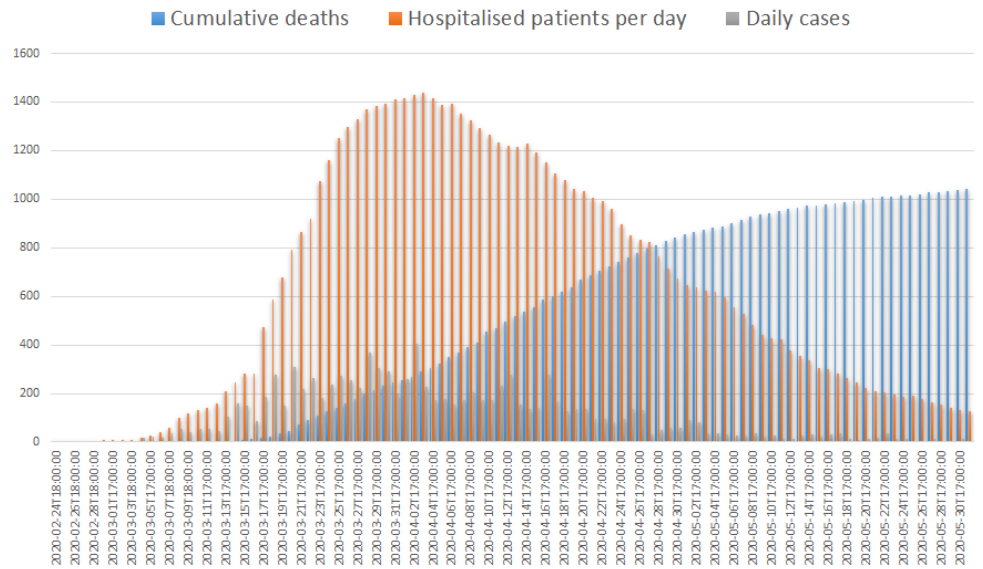
Figure 1. Trends of daily new cases, cumulative deaths and cumulative hospitalized patients per day, in Tuscany, from 24 February to 31 May .